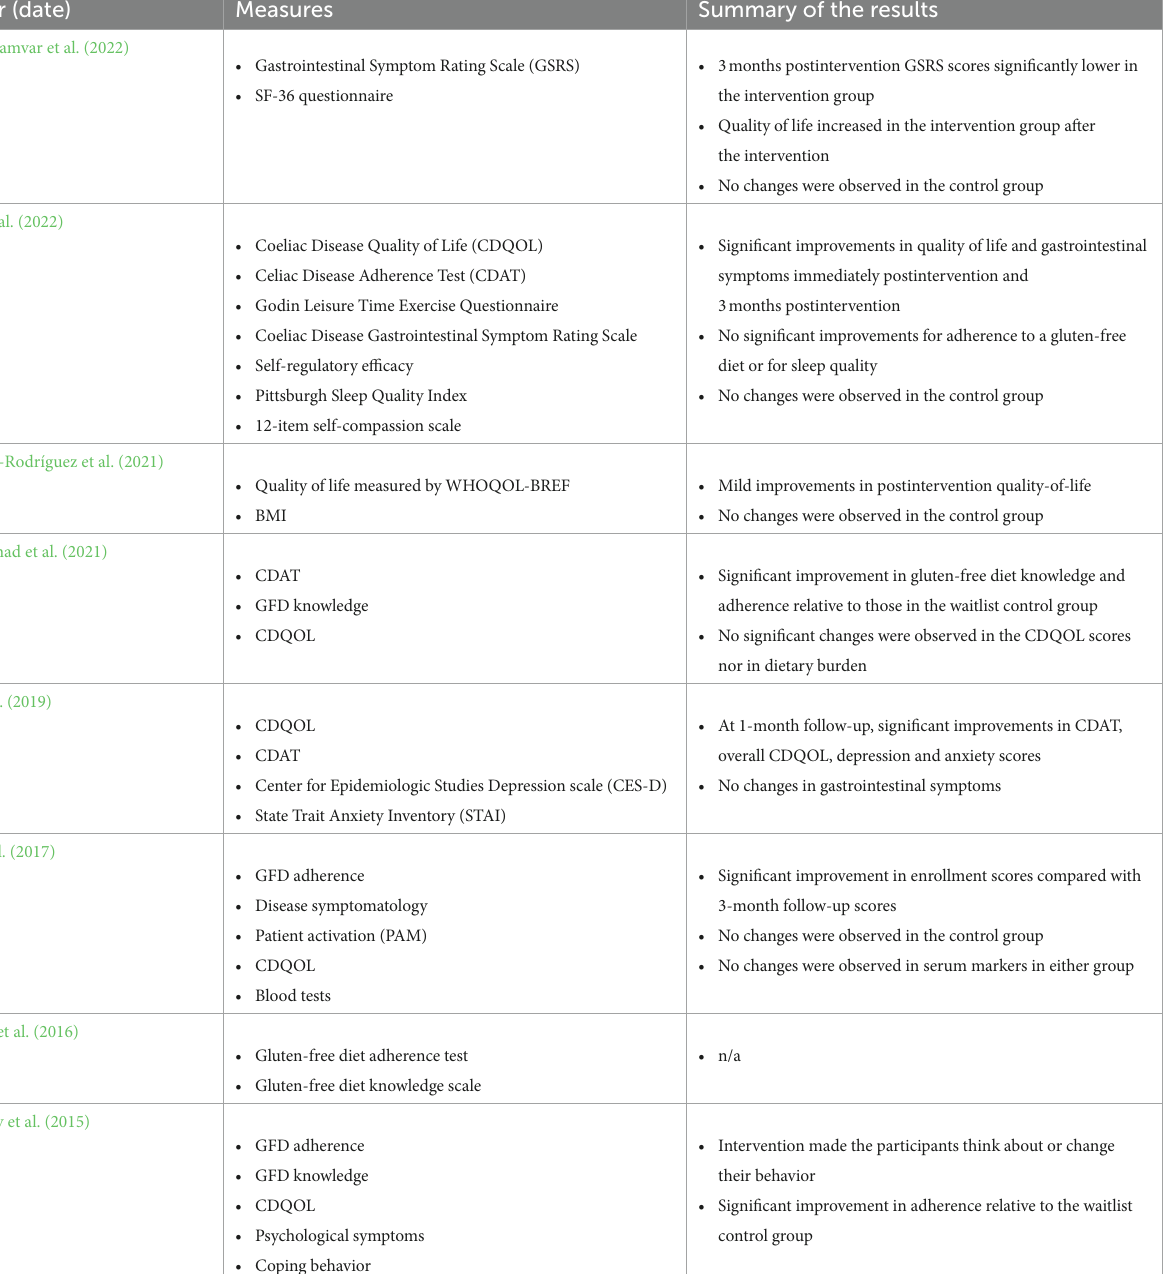
TABLE 4 Summary of the main